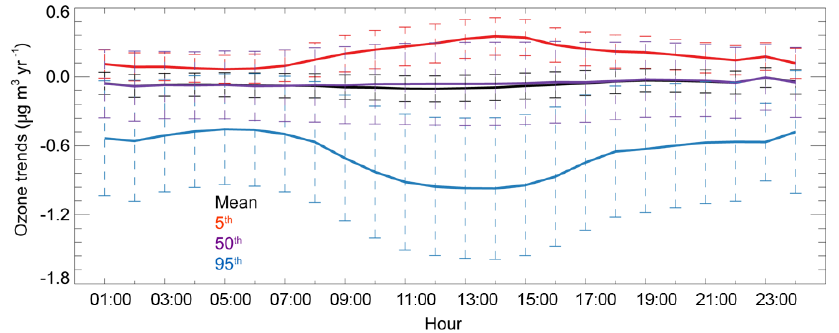
Figure 3. Trend in the observed surface ozone, averaged over Europe, calculated for the selected 93 sites. The black line shows the 1995– 2014 linear trends in the deseasonalized European monthly ozone anomalies for each hour of the day (local standard time), the red, purple, and blue lines depict the observed trend for 5th, 50th, and 95th percentile ozone, respectively, and the dashed bars indicate their standard